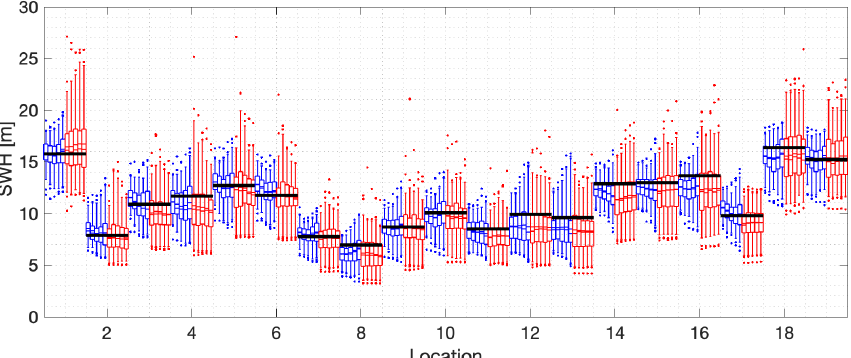
Figure 6. The 500-year return value for SWH using maximum likelihood estimation for the 100m iso-depth contour. The x axis gives the reference numbers of the 19 locations on the contour. Location numbers are given in Fig. 2. Corresponding to each location, the blue box–whiskers summarize the estimated return value from STM-E for different sample sizes 20, 30, 40, 50, and 60; the red box–whiskers summarize the estimated return values from single-location analysis for different sample sizes. For each blue and red cluster of box–whiskers corresponding to a specific location, return value estimates for the increasing sequence of sample sizes are plotted sequentially outwards from the centre of the cluster. For all box–whiskers, the box represents the inter-quartile interval, and the median and mean are shown as solid and dashed lines. Whiskers represent the 2.5% to 97.5% interval. Exceedances of this 95% interval are shown as dots. The black horizontal line for each location corresponds to the empirical estimate of the return value obtained directly from the full synthetic cyclone data for that